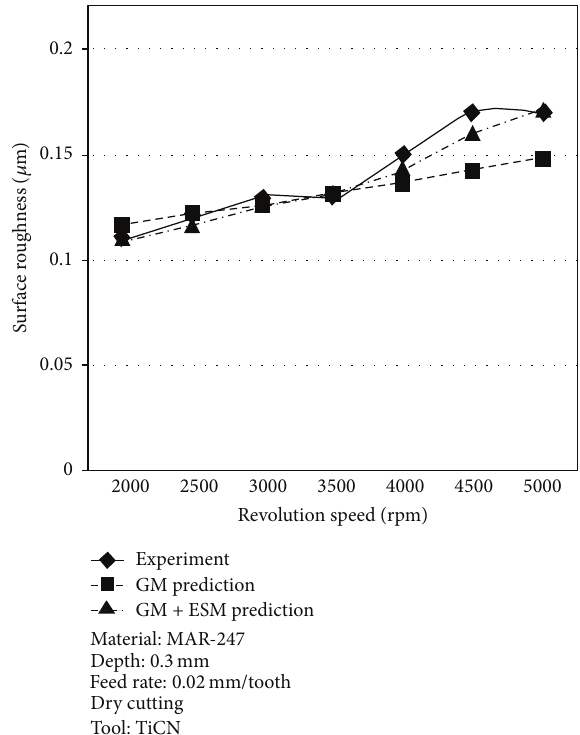
Figure12:Relationshipsbetweenrevolutionspeedofmainshaftand surface